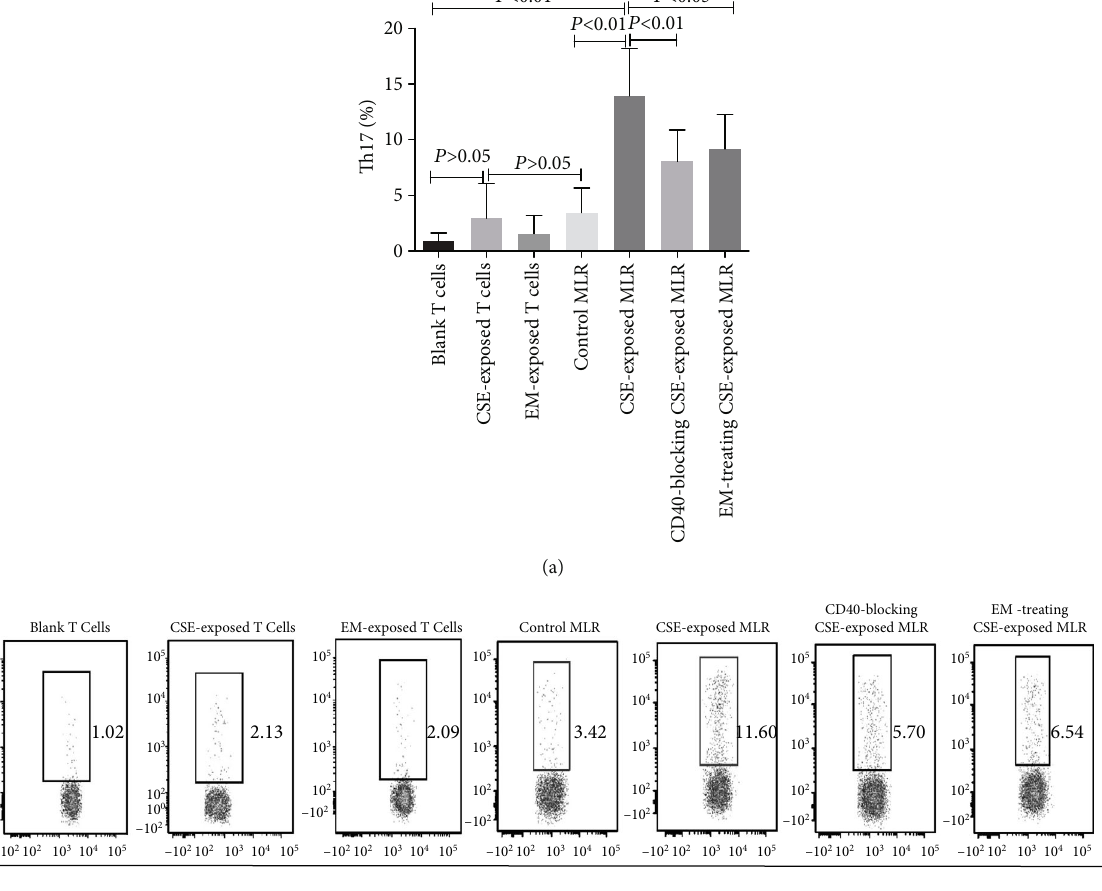
Figure 2: E ff ects of CSE and EM on DCs polarizing CD4 + T cells into Th17 cells. Numbers of Th17 cells in the various groups are shown ( n = 6 ). (The height of the bar chart represents the mean and the height of the error line indicates the standard errors of the means in the